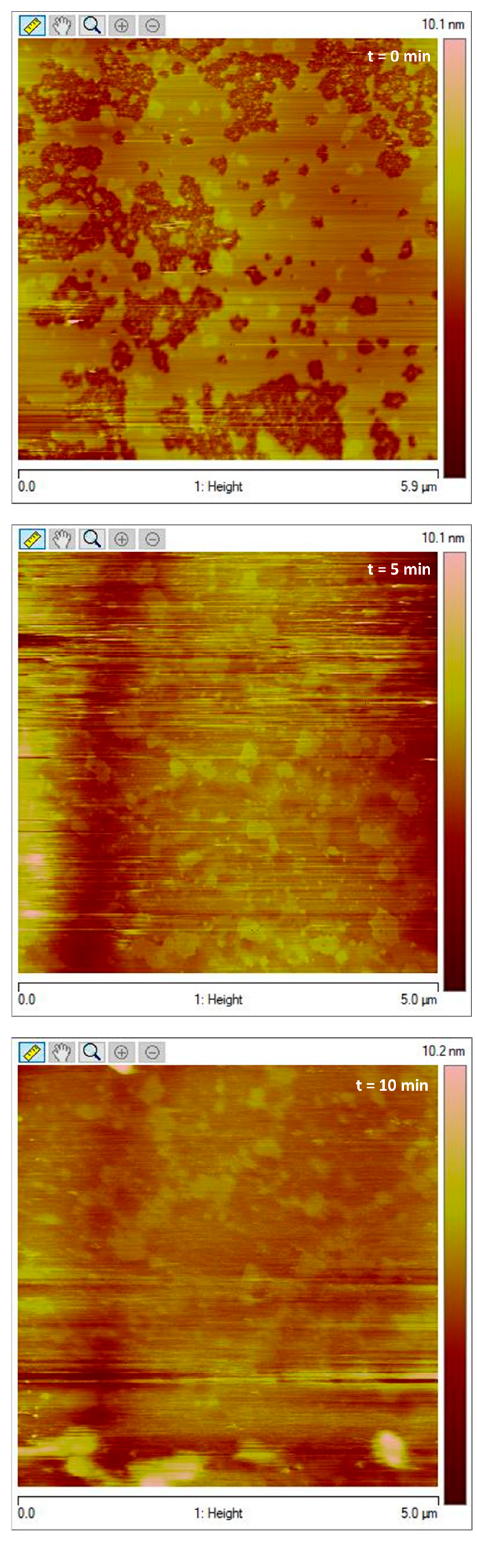
Figure 8. Erosion and solubilization of the SLBs at high peptide concentrations. In agreement with these observations, determinations of the zeta potential of the lip- osomes were consistent with the incorporation of G1OLO-L 2 OL 2 into the vesicles. How-